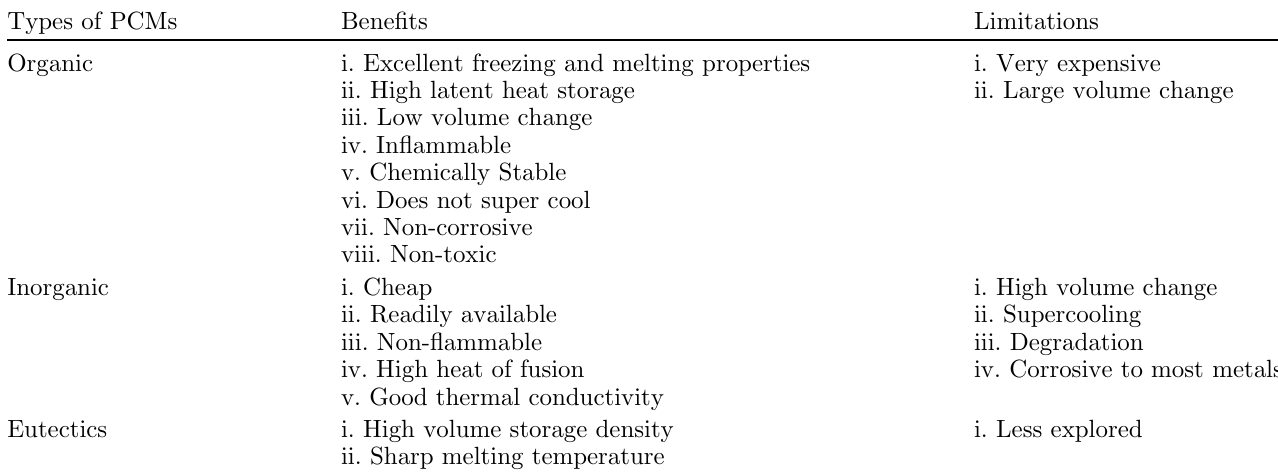
Table 1. Types and properties of